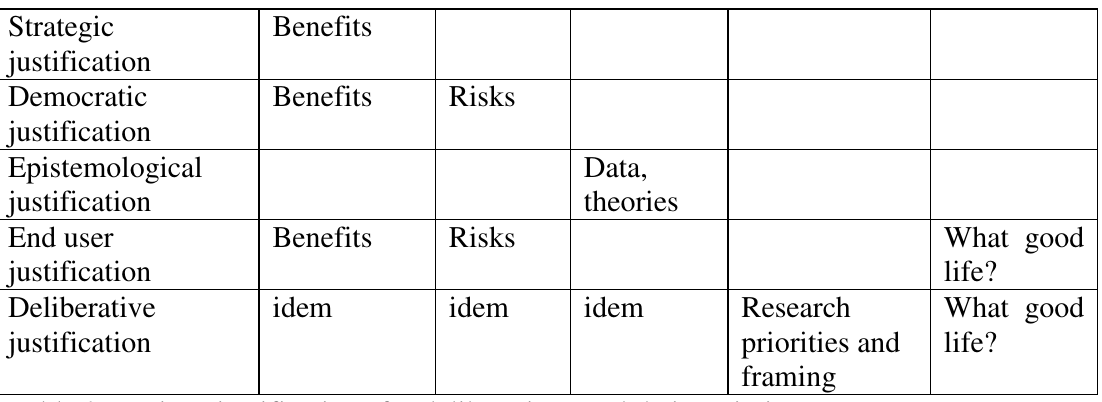
Table 2. Various justifications for deliberations and their main items